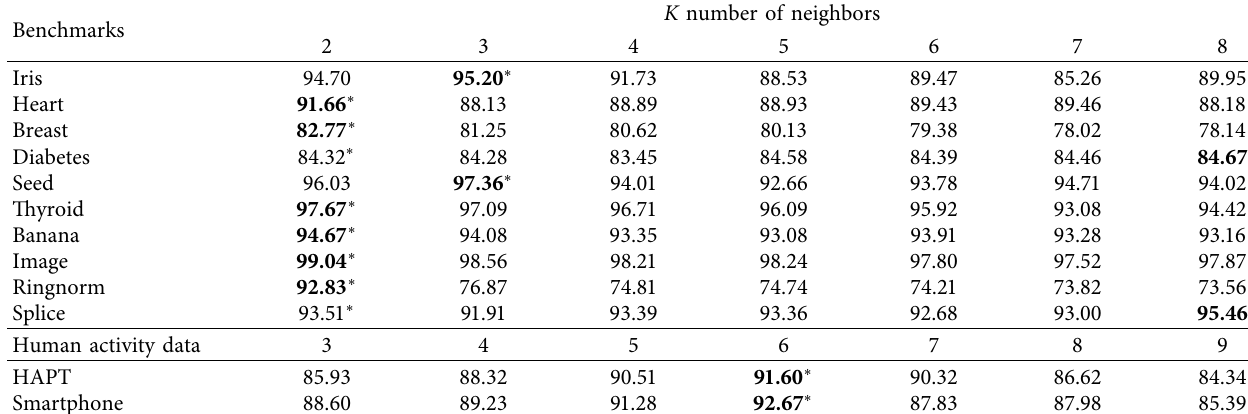
Table 4: The distribution of K neighbors in benchmarks and real-world data.